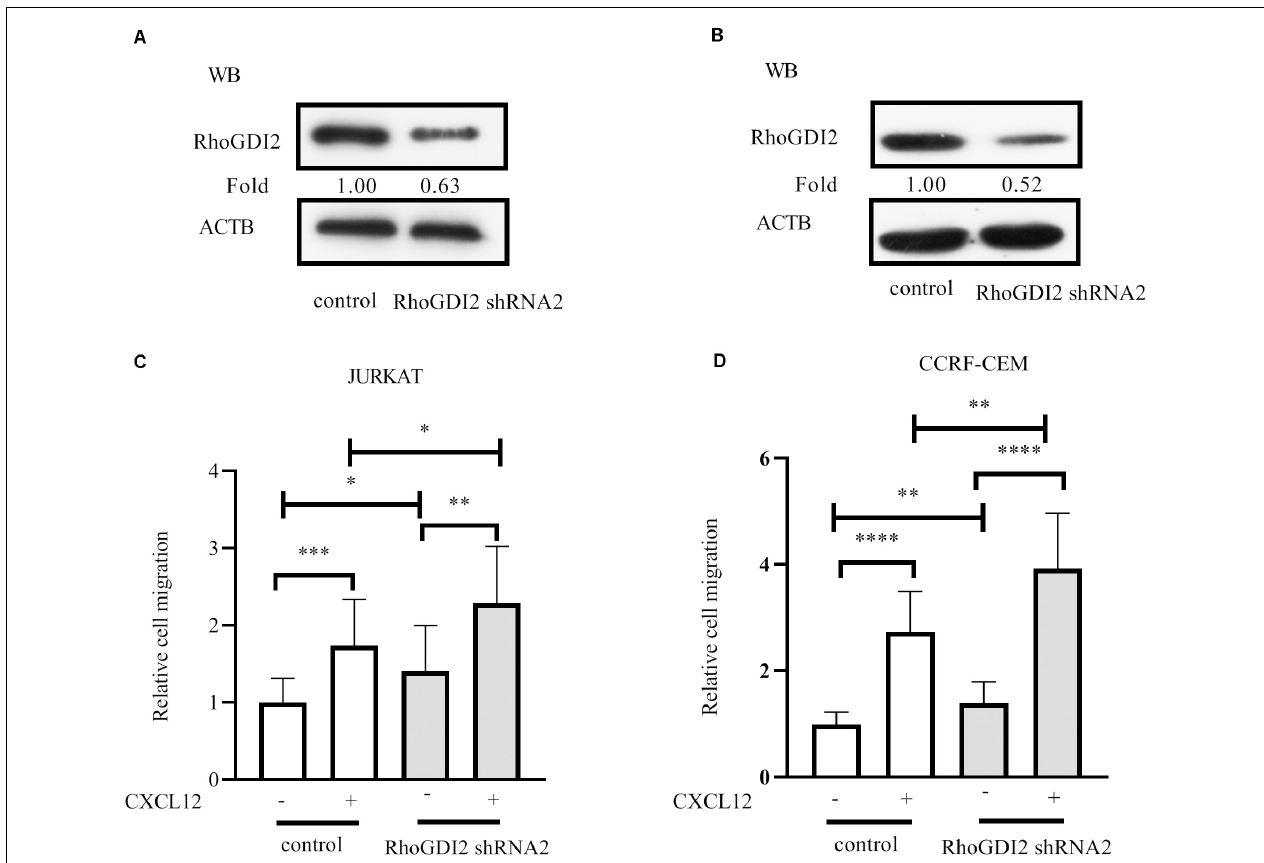
FIGURE 2 | RhoGDI2 negatively regulates T-ALL cell migration toward CXCL12. (A,B) shRNA to RhoGDI2 or control shRNA was transfected into HEK293T to generate lentivirus, JURKAT or CCRF-CEM cells were infected, and the interference efficiency was detected by Western blot, using RhoGDI2 antibody. (C,D) shRNA that successfully downregulated RhoGDI2 was used in the transwell assay. Each experiment was repeated at least three times. Western blot bands were analyzed using Image Pro Plus 6.0, and fold changes of RhoGDI2 were normalized according to ACTB. ACTB was used as the loading controls. * p < 0.05, ** p < 0.01, *** p < 0.001, **** p <